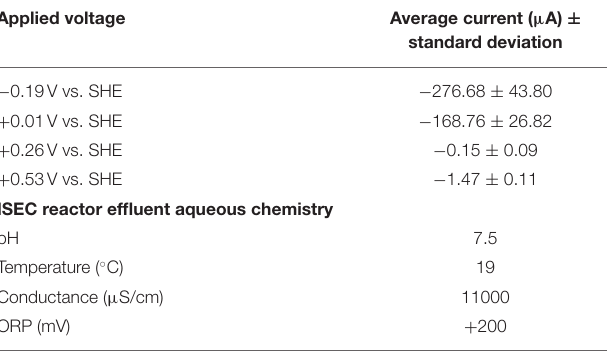
TABLE 2 | Mean current (last 40 days) observed at various redox potentials in the in situ electrochemical colonization (ISEC) reactor and aqueous water chemistry of ISEC reactor